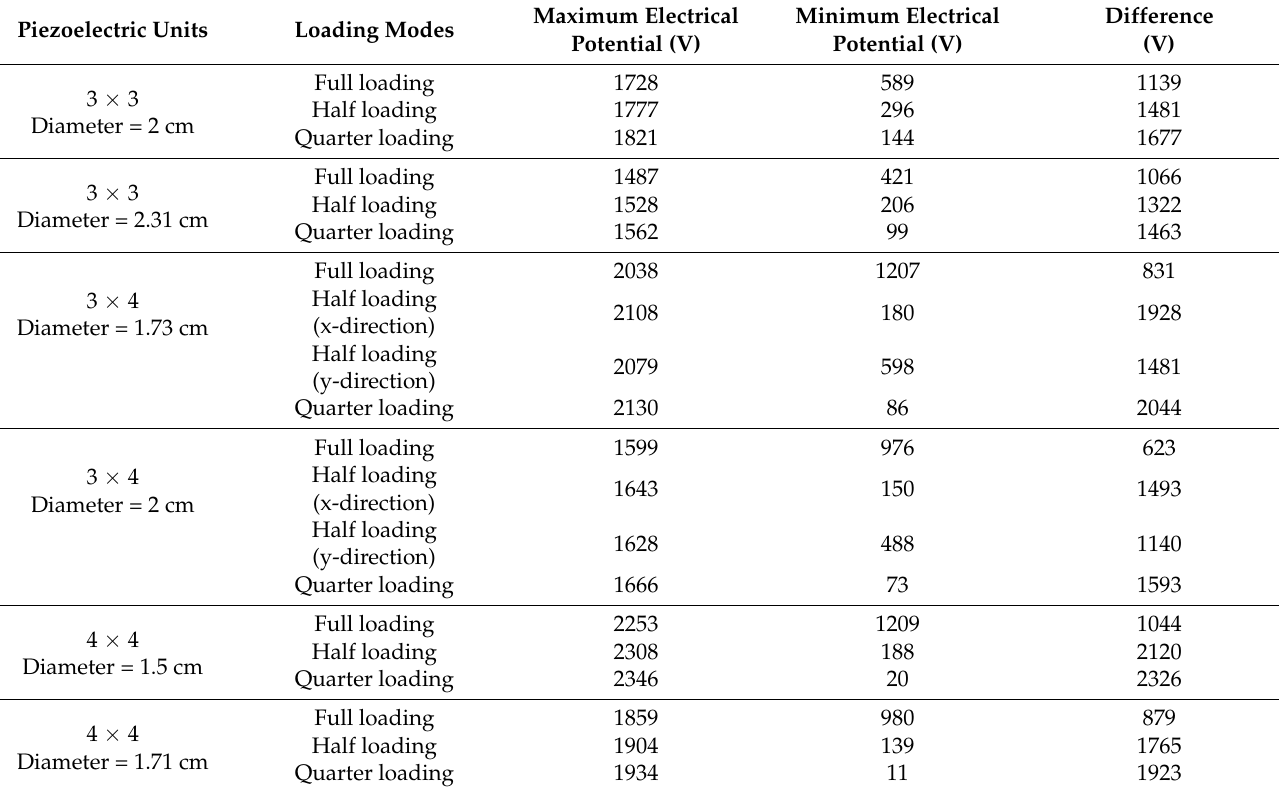
Table 3. Electrical potential difference in